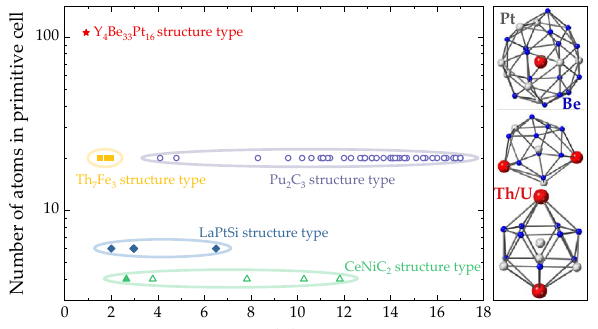
Figure 1. Crystallographic complexity and superconductivity in Th-based compounds. Left: The relation between the number of atoms per unit cell, i.e., structural complexity 26,27 , and the superconducting temperature T c for the three previously reported classes of Th-based NCSCs and for the newly discovered NCSC Th 4 Be 33 Pt 16 (structure type Y 4 Be 33 Pt 16 ). Right: Coordination polyhedra around the Th/U and Pt atoms in Th/ U 4 Be 33 Pt 16